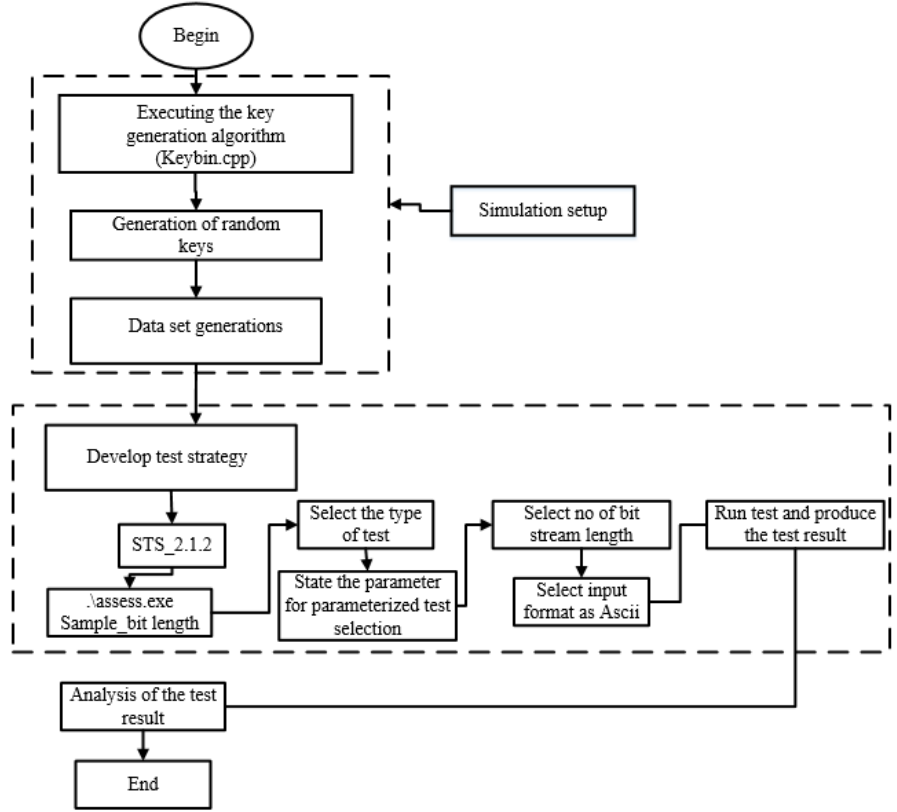
Figure 2. Research flow diagram .